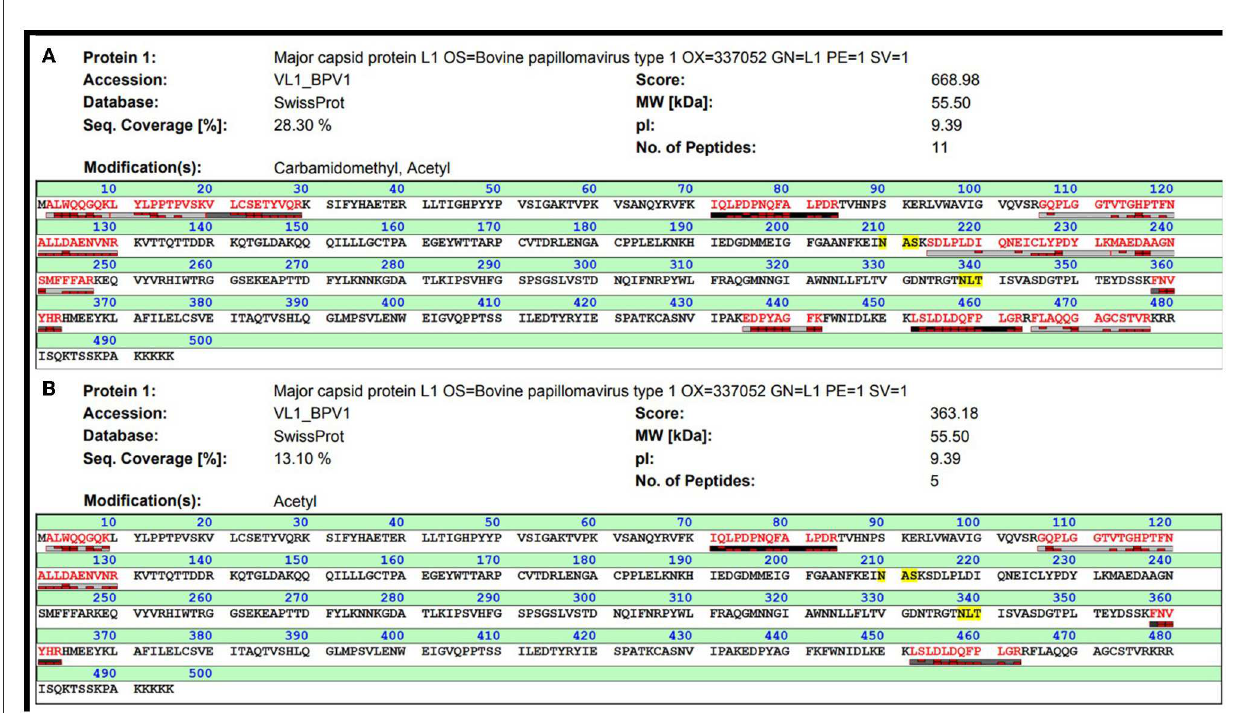
FIGURE2 MALDI-TOF analysis of purified BPV1 L1 after in-gel tryptic digestion. Both protein bands separated by SDS-PAGE (see Figure 1) were processed for in-gel digestion, and the obtained peptides were analyzed by nLC-MALDI-TOF/TOF MS/MS. The identification results for the top and bottom bands are shown in (A, B) , respectively.